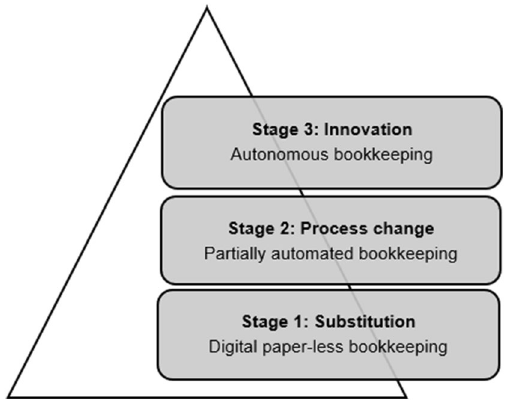
Fig. 1 Stages of digitalisation in